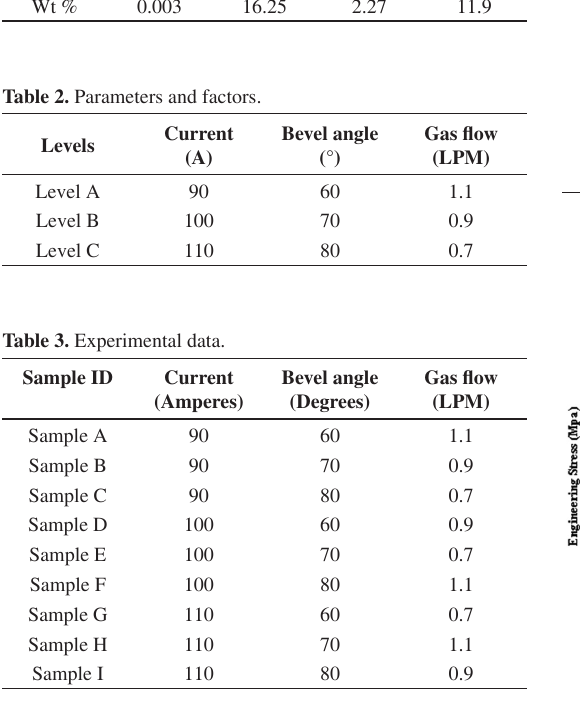
Figure 1. Tensile graph for sample I.